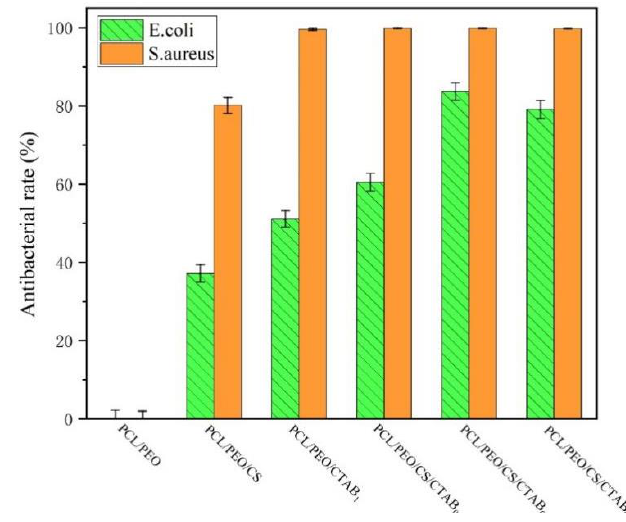
Figure 9. Images of the antibacterial rate of composite spinning